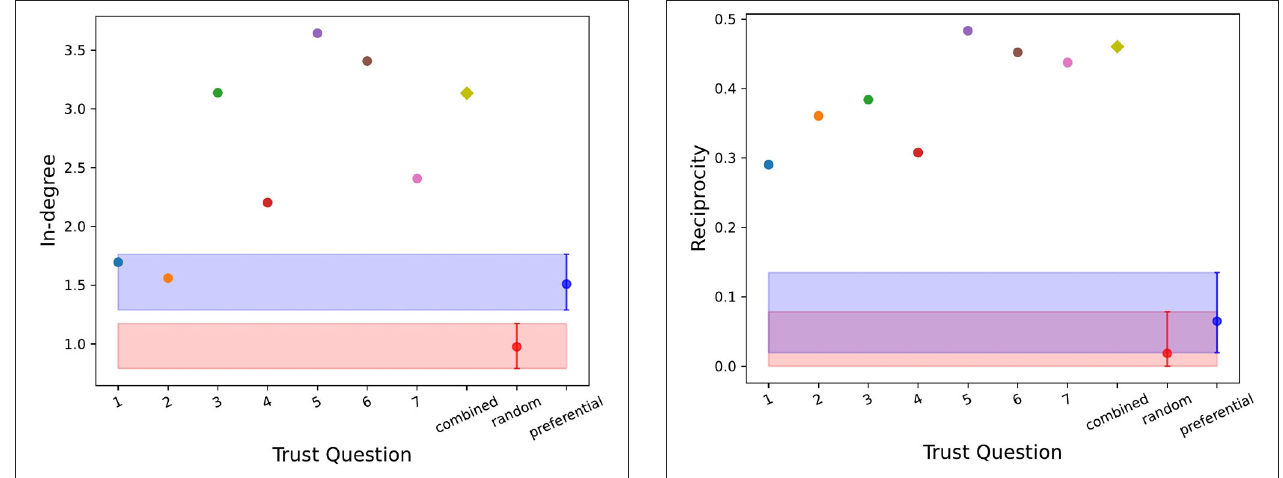
FIGURE 4 | The reciprocity for each trust question (i.e., dimension of trust), the combined trust network (yellow diamond) and the random (in red with the mean and 2.5 and 97.5 quantiles around it) and preferential (in blue with the mean and 2.5 and 97.5 quantiles around it) null models. All the networks were beyond the 95% confidence interval for each null